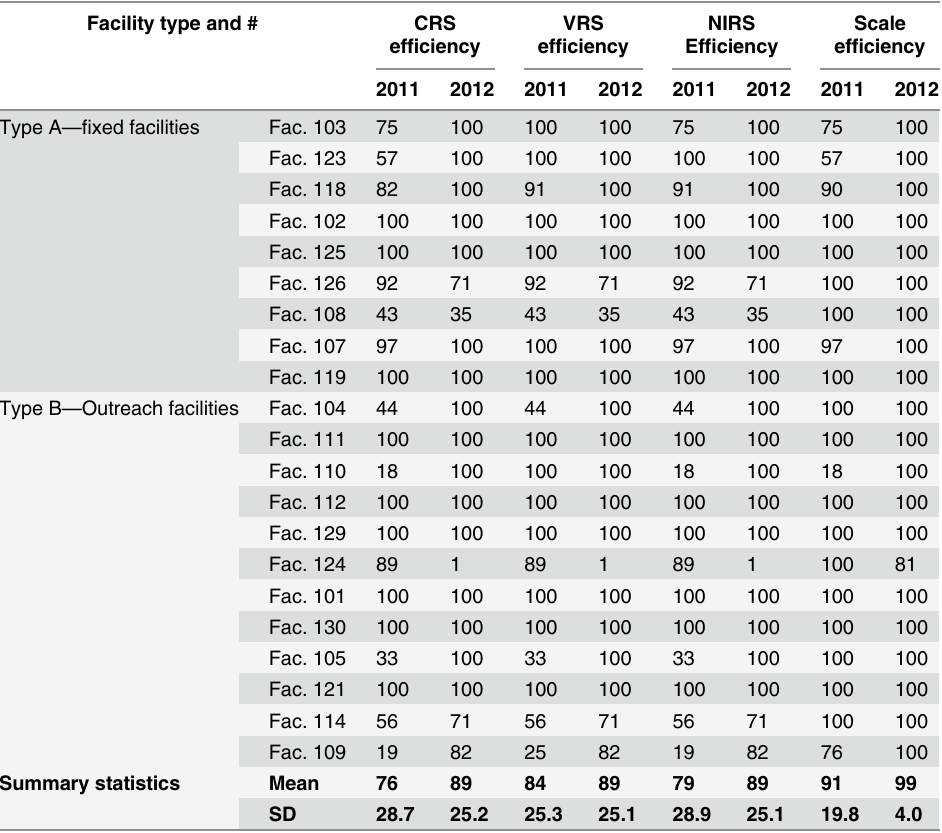
Table 3. Output oriented Technical Ef fi ciency Scores of facilities by year, type, and return to scale (n =